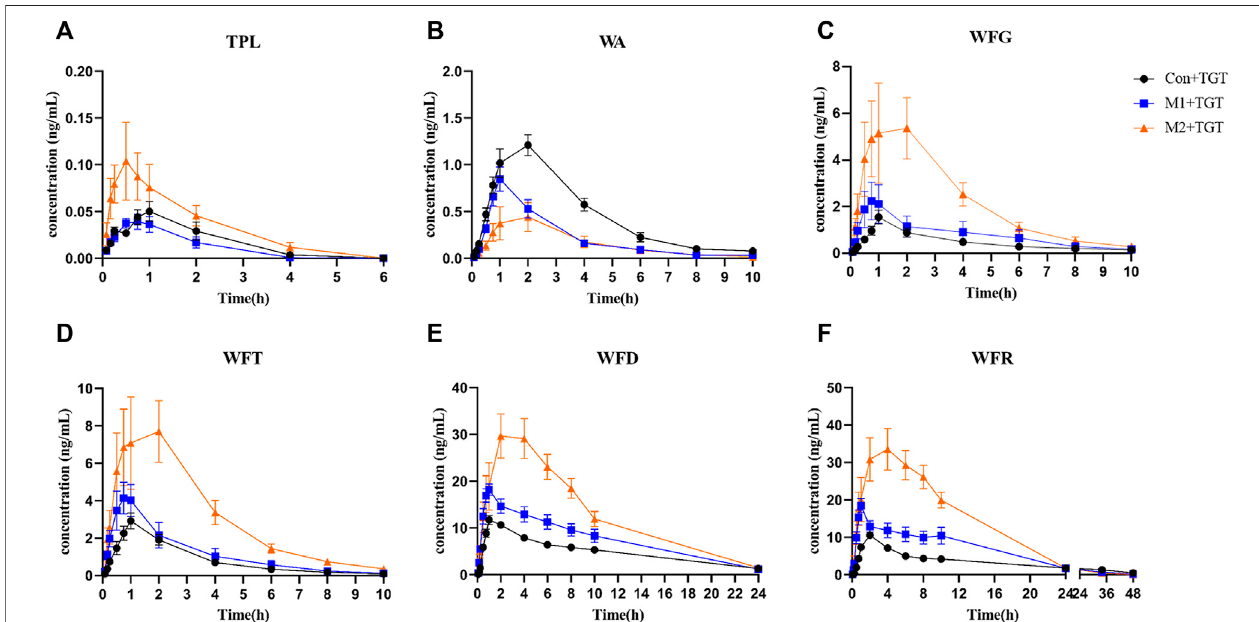
FIGURE 5 | Plasma concentration – time pro fi les of the six key TGT components in the normal and two types of adriamycin-induced-NS rat after a single TGT oral gavagedoseof10 mg/kg(mean±SD,n=7).Thenormalrats,Con+TGT,blackcircle C ;theearly-stageNSrats,M1+TGT,bluesquare ;theadvanced-stageNSrats, M2+TGT, orange triangle . TPL (A) , WA (B) , WFG (C) , WFT (D) , WFD (E) , WFR (F)